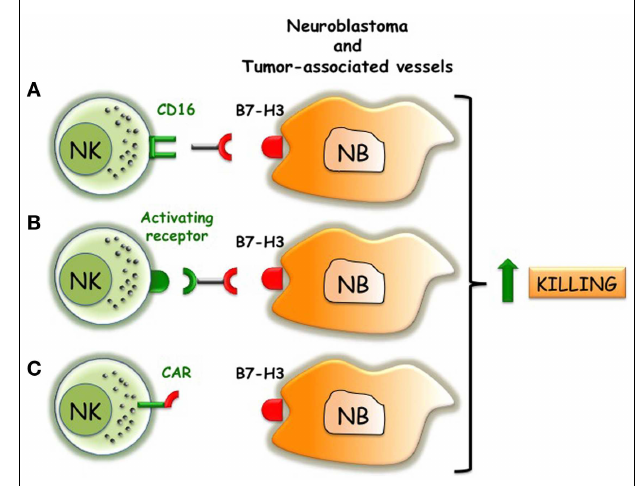
FIGURE 3 | Possible immunotherapeutic approaches that target B7-H3 and trigger NK cell function . (A) Anti-B7-H3 antibodies induce ADCC of NK cells against NB. (B) Bi-specific antibodies that react with B7-H3 on NB and trigger activating receptors on NK cells. (C) NK cells engineered with B7-H3-specific CAR that transduce activating signals via CD3